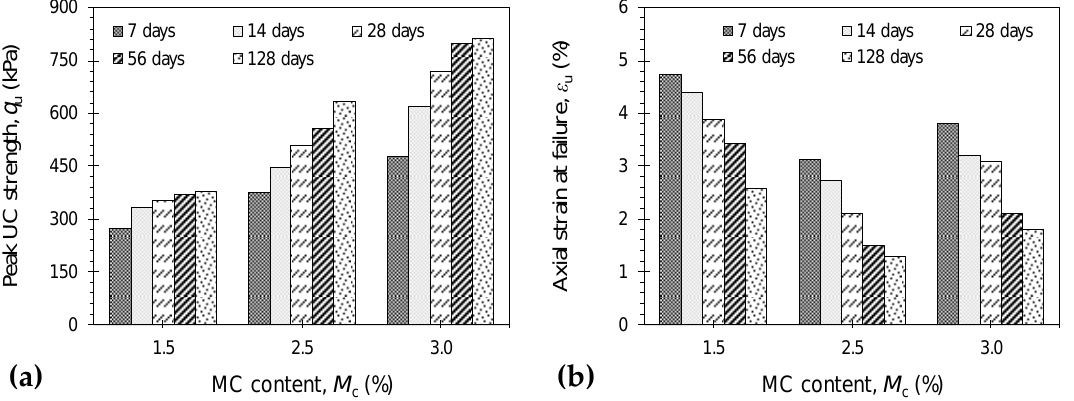
Figure 1. Variations of ( a ) peak UC strength q u and ( b ) axial strain at failure ε u against MC content for the samples tested at various curing times (i.e., M x F y T z where x = {1.5, 2.5, 3.0}, y = {0} and z = {7, 14, 28, 56, 128}).